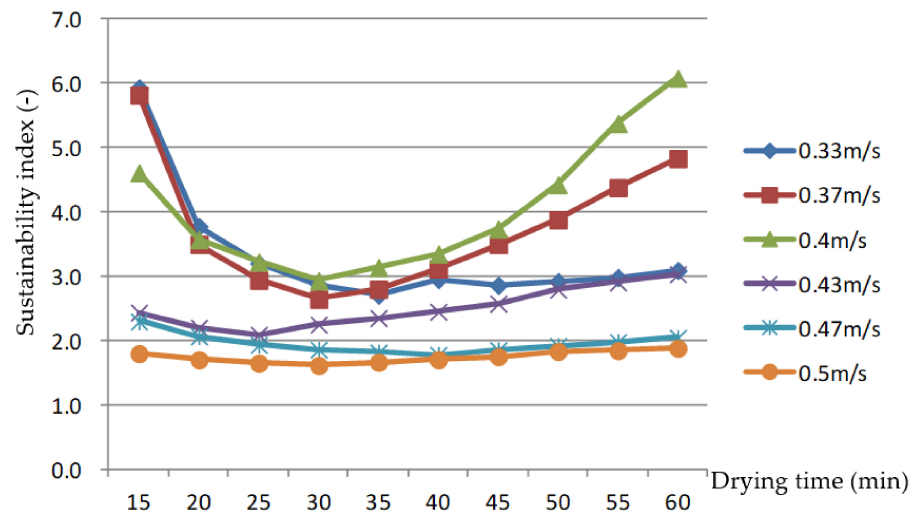
Figure 13. The changes in sustainability index rate with drying time at different air